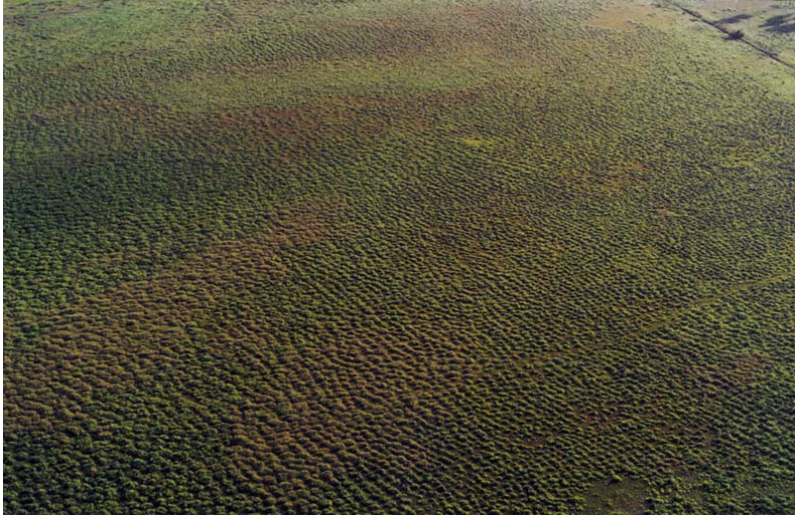
Figure 9. Small raised fields covering a savanna near